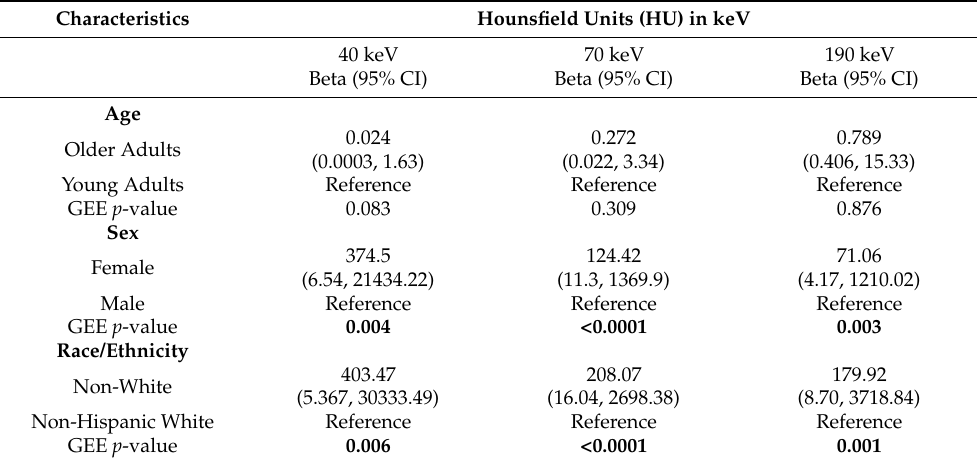
Table 4. Multivariable generalized estimating equations of characteristics associated with natural crystalline lens attenuation measured at three energy levels on Dual Energy Computed Tomography (DE-CT) (N = 198 eyes in 103